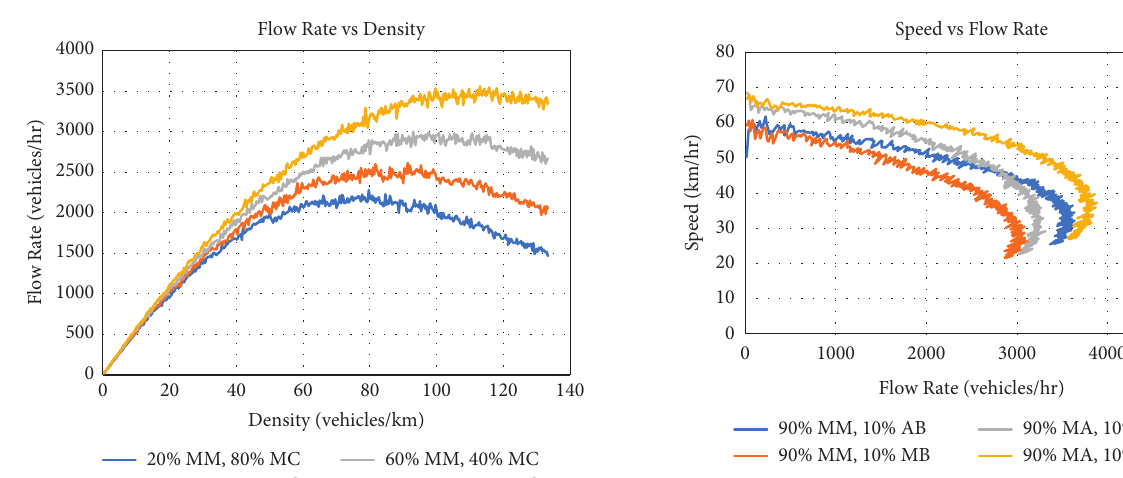
Figure 40: Speed vs. flow rate fundamental diagrams for different compositions of MA, MM, AB, and MB.